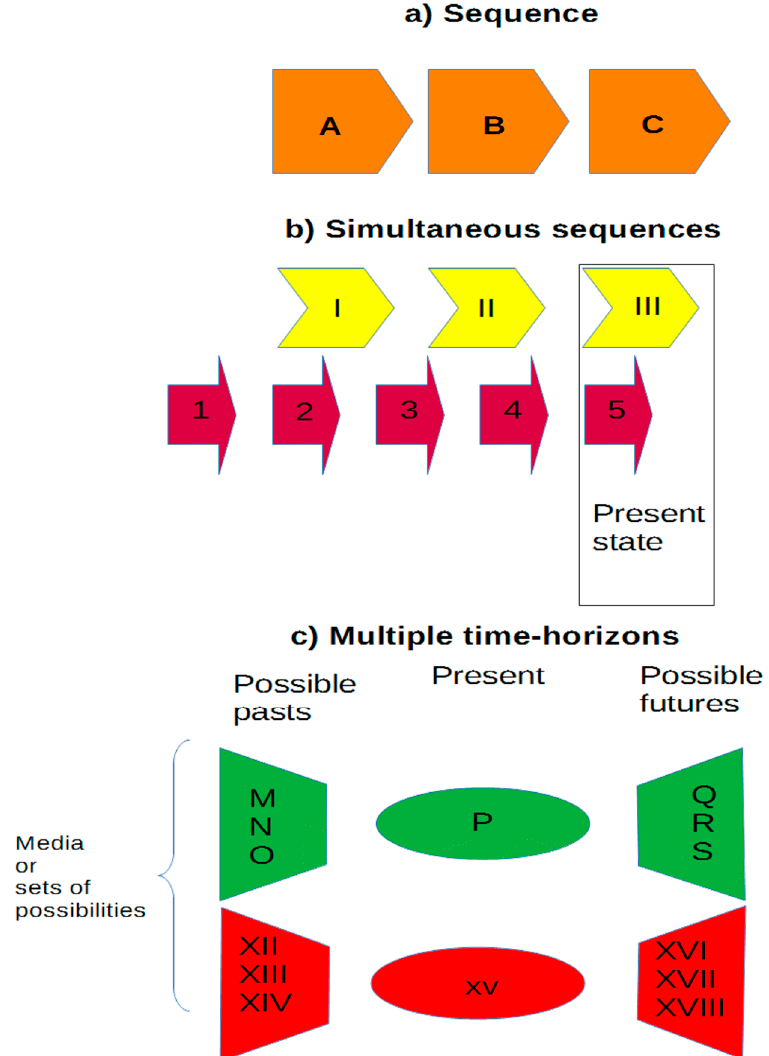
Figure 2. Some temporal patterns produced by the internal states of a complex system: ( a ) Shows the simplest case of a sequence; ( b ) represents, on the one hand, the simultaneity of di ff erent operations, and on the other, their non-simultaneity for they own di ff erent temporal horizons (represented here as di ff erent sequential lengths); and ( c ) pictures the di ff erent time-constellations that can be built departing from di ff erent (and also, simultaneous) presents—a mere sequence can be formed, but not necessarily, it is just one possibility among